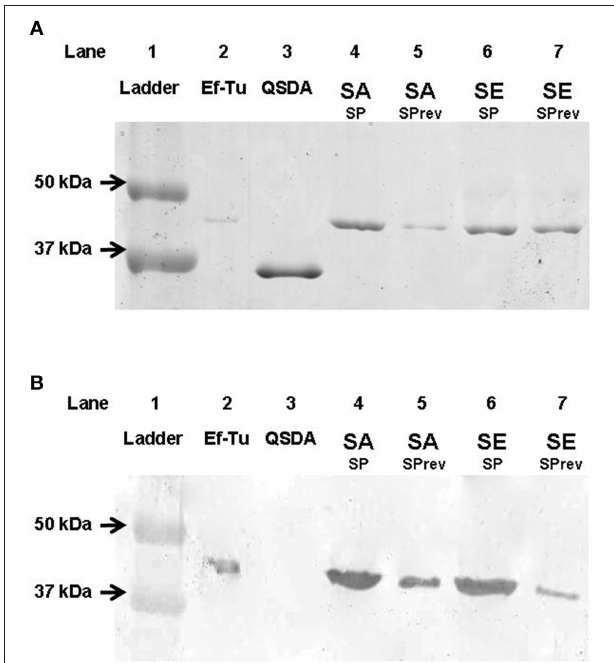
FIGURE 8 | SDS-PAGE analysis of S. aureus and S. epidermidis Substance P (SP) binding proteins separated by immunoprecipitation and labeled by colloidal Coomassie Blue G250 staining (A) and identified by western blot after transfer on nitrocellulose gel using P. aeruginosa Ef-Tu polyclonal antibidodies (B). Line 1, ladder; Line 2, P. aeruginosa Ef-Tu (mass marker and positive control for western blot); Line 3, QSDA protein (negative control for western blot); Line 4, Substance P treated S. aureus membrane extracts (SA SP); Line 5, Substance P reverse treated S. aureus membrane extracts (SA SPrev); Line 6, Substance P treated S. epidermidis membrane extracts (SE SP), Line 7: Substance P reverse treated S. epidermidis membrane extracts (SE SPrev). Results are representative of three independent